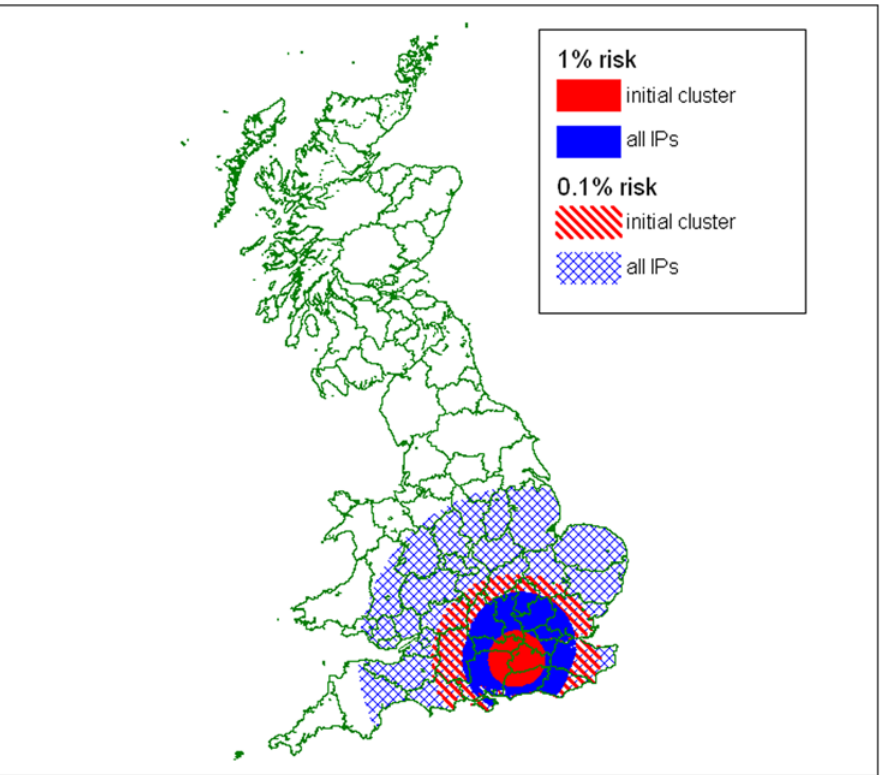
Figure 2. Suggested Restriction Zones with an escape risk of less than 1% and 0.1%, following the Foot-and-Mouth outbreak in the UK in 2007 (based on a predicted mean basic reproduction